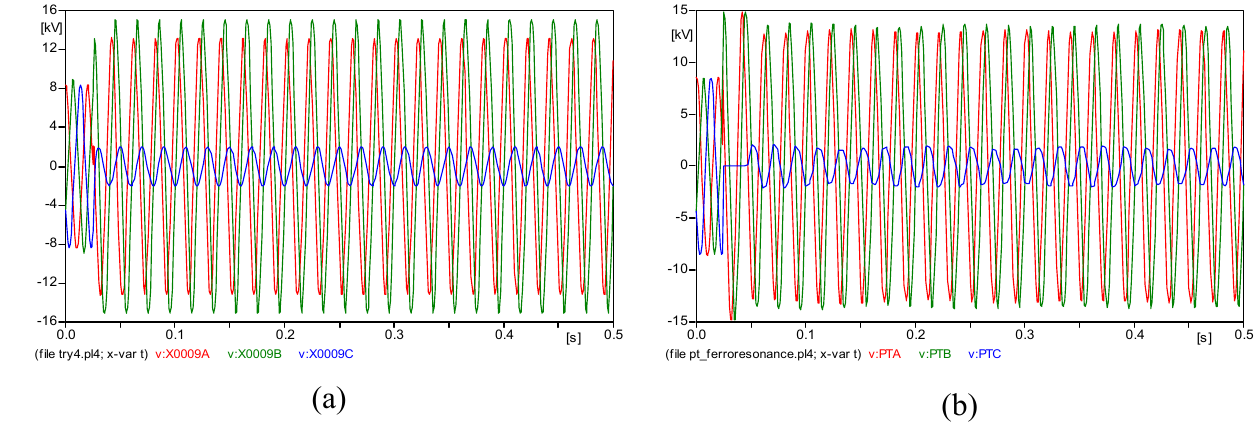
Figure 9. ( a ) Single phase-to-ground; ( b ) Fundamental